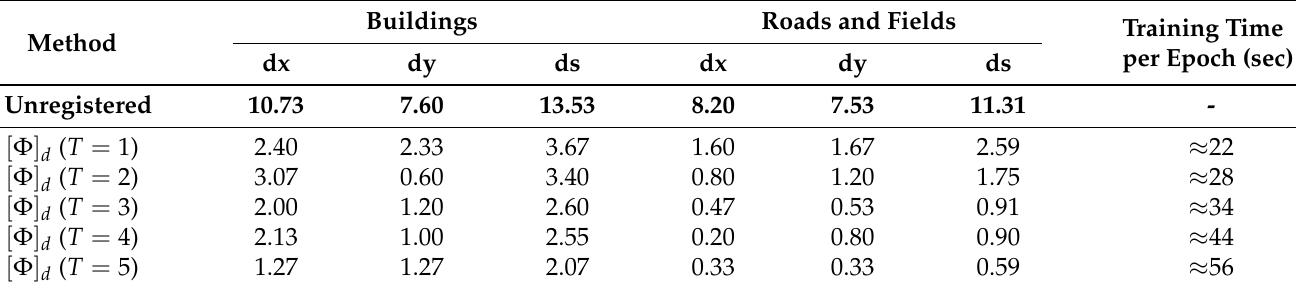
Table 1. Results from the ablation study on the testing part of Attica VHR dataset. Landmark location errors are calculated for deformable registration models that are trained with various time steps ( T ). The last column indicates the time needed by each framework to complete one training